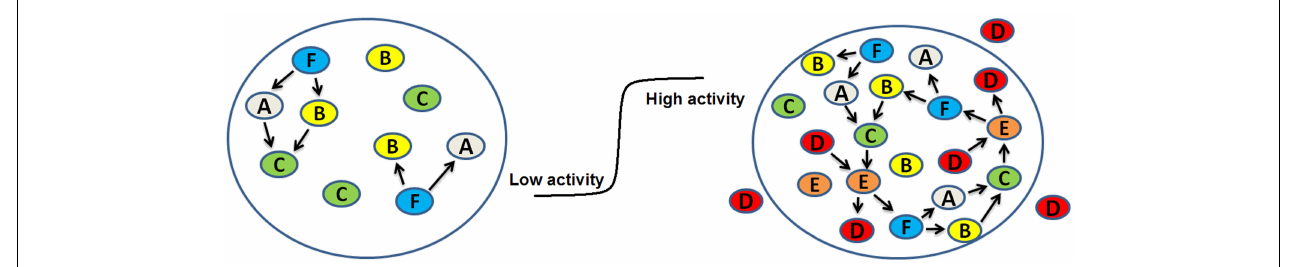
can come from outside or arise by chance inside, the situation suddenly changes (right panel). In this hypothetical model, D now catalyzes the reaction of C turning into E which then breaks down to D and F.Therefore, an autocatalytic cycle emerges and the reaction network undergoes a phase transition (middle panel) from a state of low activity to a state of high activity which represents life.